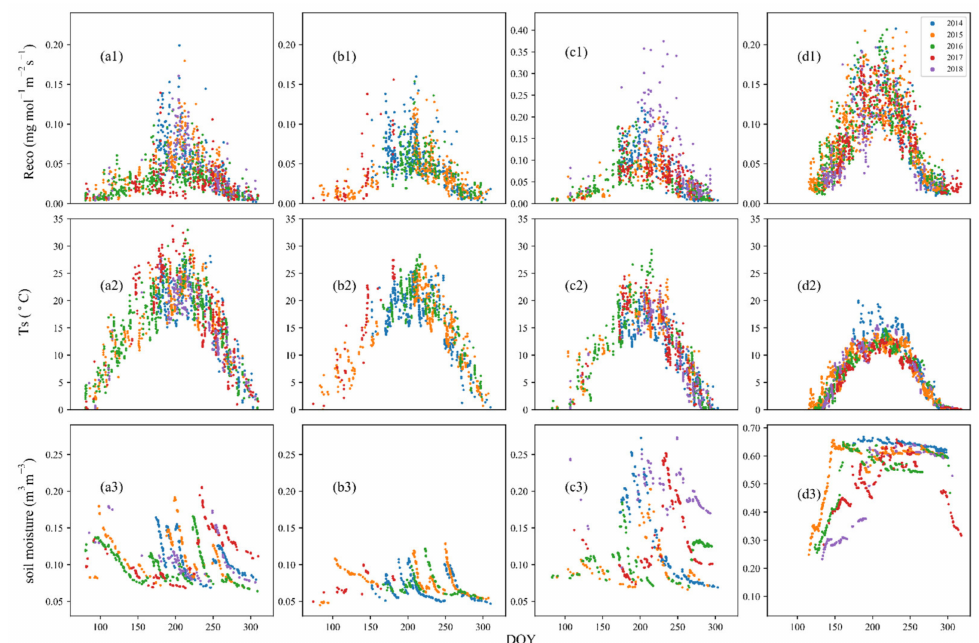
Figure 2. Changes in ecosystem respiration (R eco ), soil temperature (Ts) and soil moisture at four sites in different years: ( a1 – a3 ) are for site SHB in 2014–2018; ( b1 – b3 ) are for site DRY in 2014–2017; ( c1 – c3 ) are for site TEMP in 2014–2018; and ( d1 – d3 ) are for site MDW in 2014–2018. The measurements in each year are represented by a unique